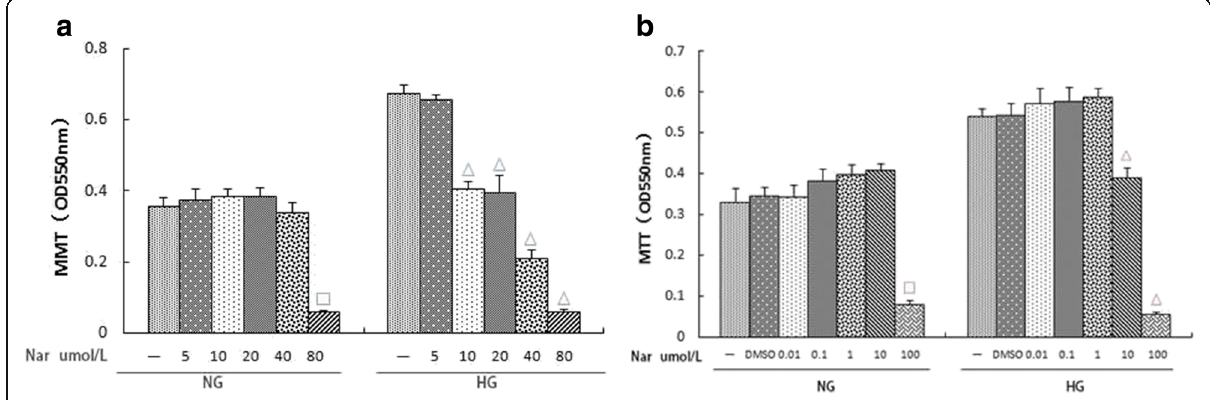
Fig. 7 a , b Effects of ( a ) different naringin concentrations (0,0.01,0.1, 1.00,10.00 and 100umol/L),( b ) different naringin concentrations (0,5,10,20,40 and 80 umol/L) on the activity of normal glucose and proliferation of high glucose in rat glomerular mesangial cell.Proliferation was measured by MTT. NG:normal control group,HG:high glucose group,DMSO:DMSO content of 1% group.Data are presented in mean ± SD, □ P < 0. 05 versus normal control group, △ P < 0. 05 versus high glucose